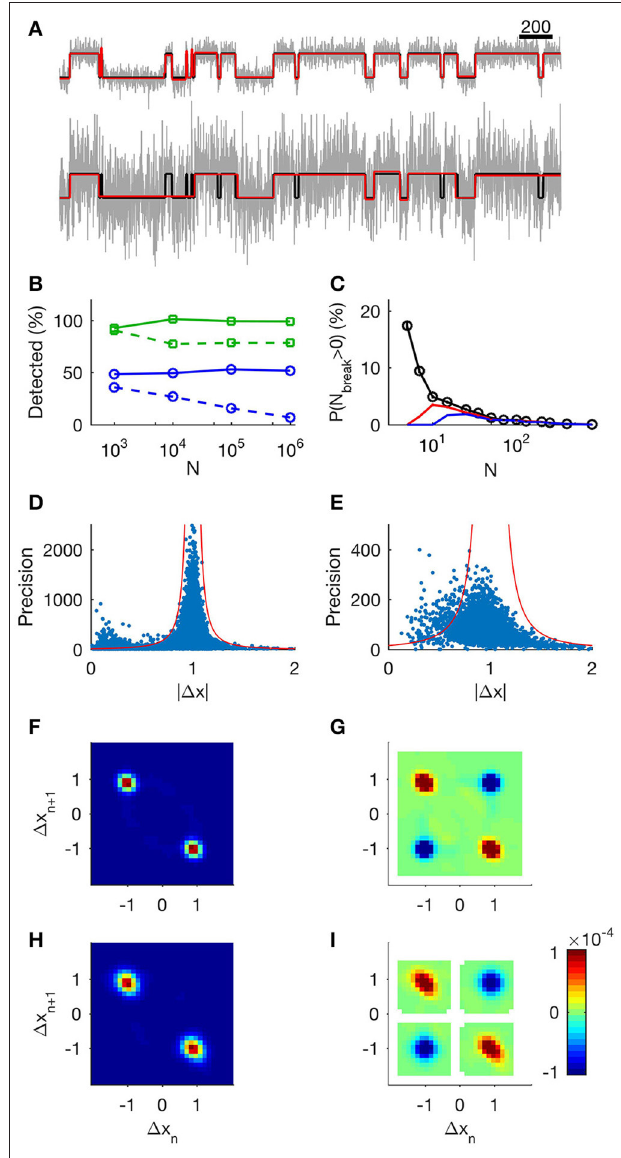
FIGURE 1 | Evaluation of the step detection method applied to synthetic data. (A) 1,000 data points of unit steps (upper, SNR = 3.3; lower, SNR = 1). Input data are shown in black, MDL-idealized data are shown in green, and true states are shown in red (note that the green and red lines often coincide). (B) The tertiary search method provides a constant frequency of event detection regardless of recording segment length. Markers show the number of detected steps relative to the number of known steps as a function of N , the number of data points in the record. Squares (green).: SNR = 3.3 Circles (blue): SNR = 1. Solid lines show results from the tertiary search, and dashed lines show the results from the binary search. (C) Analysis of probability of false events. Each data point shows mean number of false events from 5,000 sequences of uniform random numbers of length N . Black: l min = 1, red: l min = 3, and blue: l min = 5. (D,E) Analysis of precision in step estimates at SNR 3.3 and 1 respectively. Dots show precision of jump estimate as function of observed absolute jump. We calculated the precision using the length of the adjacent segments according to Equation (8). Red lines indicate 4 standard deviations from the target value at different levels of precision.